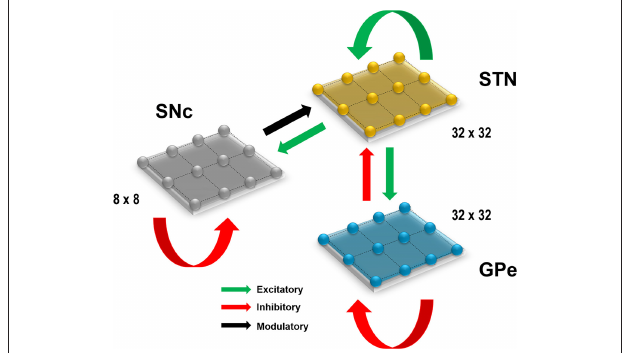
FIGURE 1 | Proposed model architecture. The model architecture of the proposed model of STN-mediated excitotoxicity in SNc. STN, SubThalamic Nucleus; SNc, Substantia Nigra pars compacta; GPe, Globus Pallidus externa.